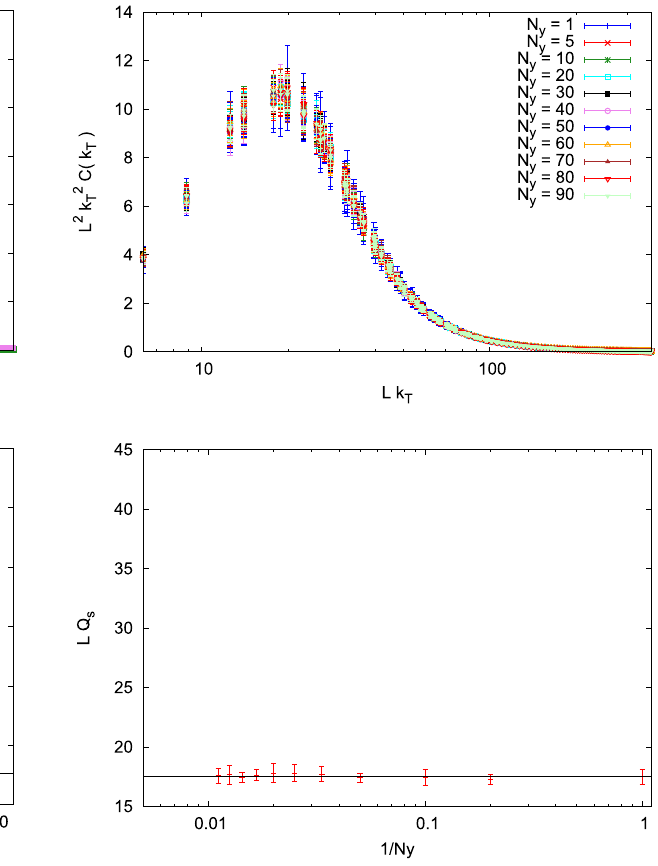
Fig. 7 Top: dependence of the s = 0 momentum-space correlator on the m regulator in Eq. (3). Bottom: dependence of the saturation scale on the mass regulator. A vanishing mass extrapolation is attempted with theconstantfitansatz f ( am ) = b ,where b isafitparameter.Datapoints with am ∼ 0 . 03 are still compatible with the extrapolated value